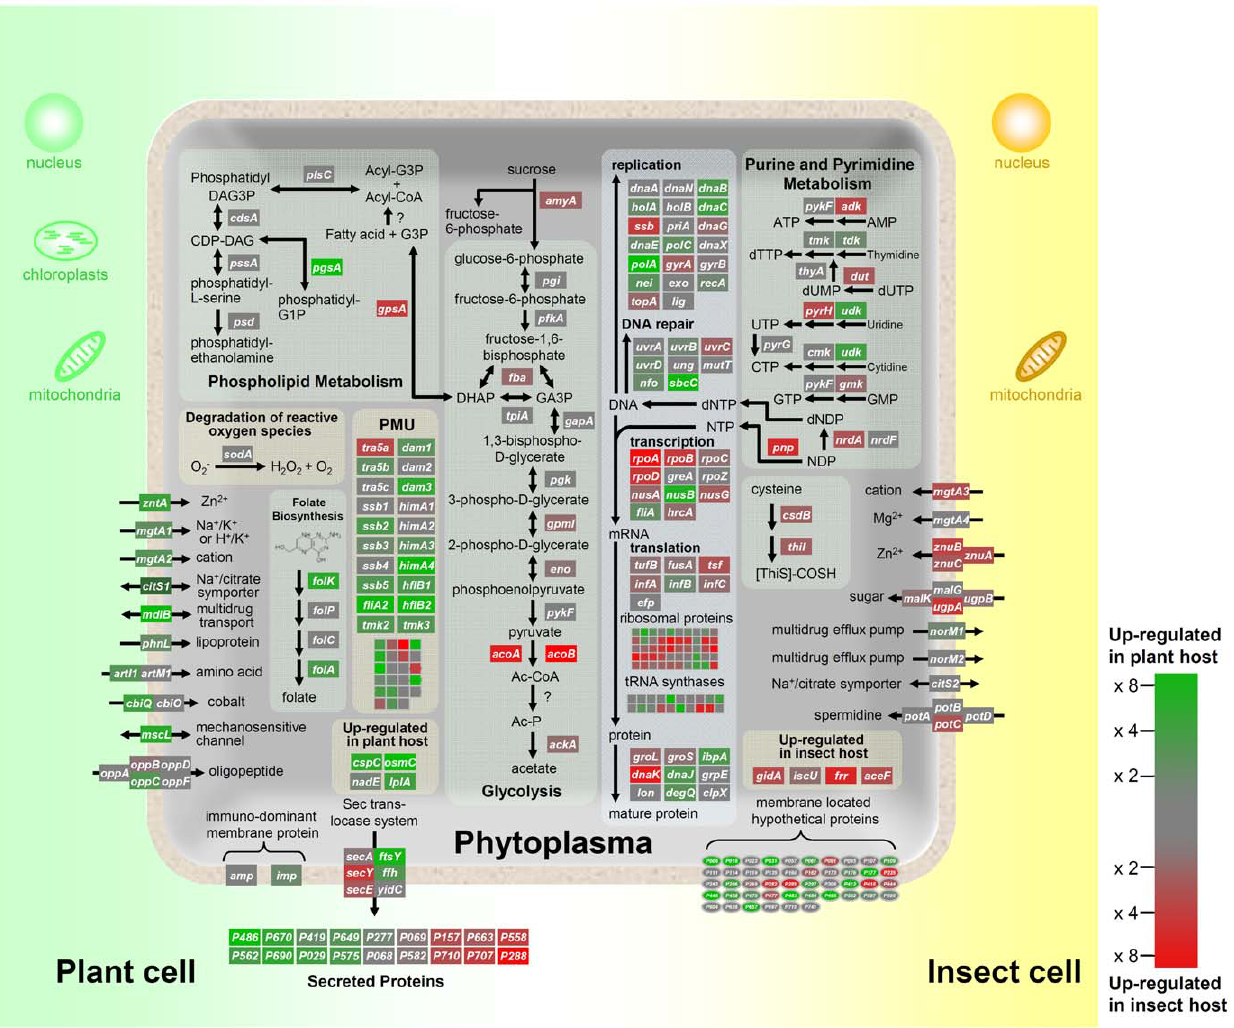
Figure 6. Overview of the phytoplasma metabolic pathways and the expression levels of each gene in plant and insect hosts. The genes upregulated in the plant host are shown in green, while those upregulated in the insect host are shown in red. Abbreviated gene names and their annotation list are shown in Table S1.